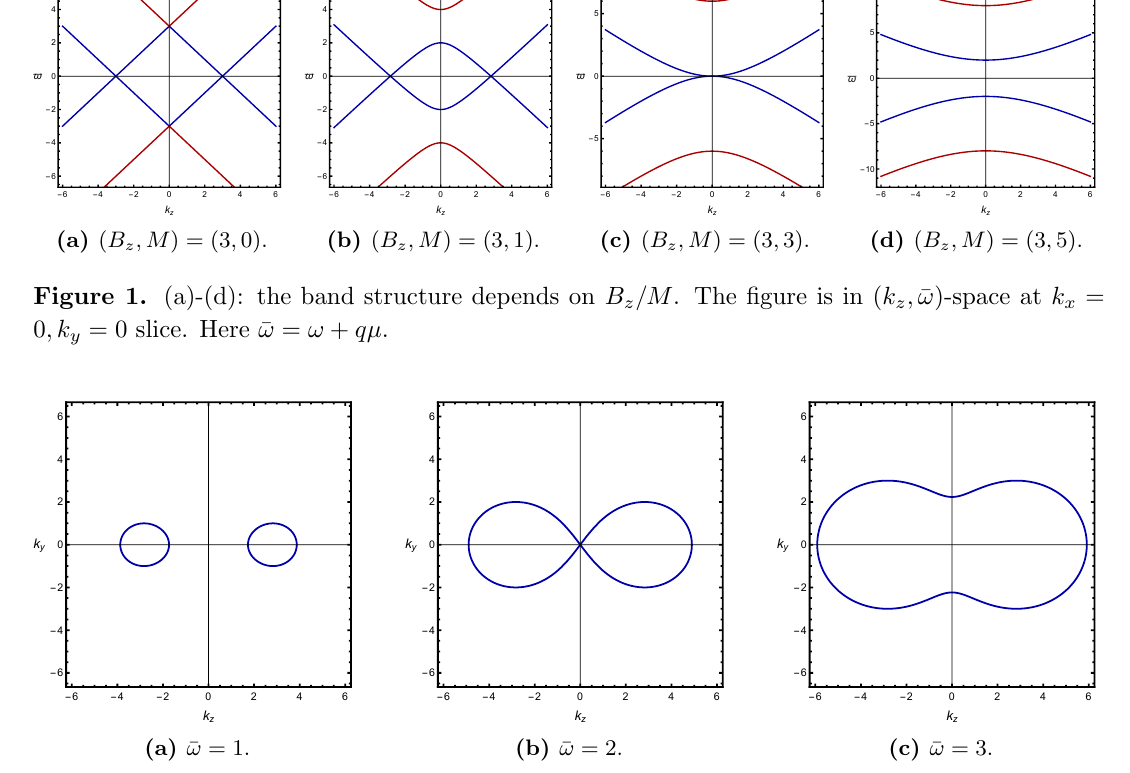
Figure 2. (a)-(c): the di(cid:11)erent (cid:22) ! slices of the band structure at k x =0 with ( (cid:22) B z ; M ) = (3 ; 1). The radius of circle decreases as (cid:22) ! apparoches to 0. This result is the same for k y = 0 plane. has the centers at the band crossing point of spectrum and it shrinks as we approach to (cid:22) ! = 0, which implies the spectrum forms cone-structure near the band crossing